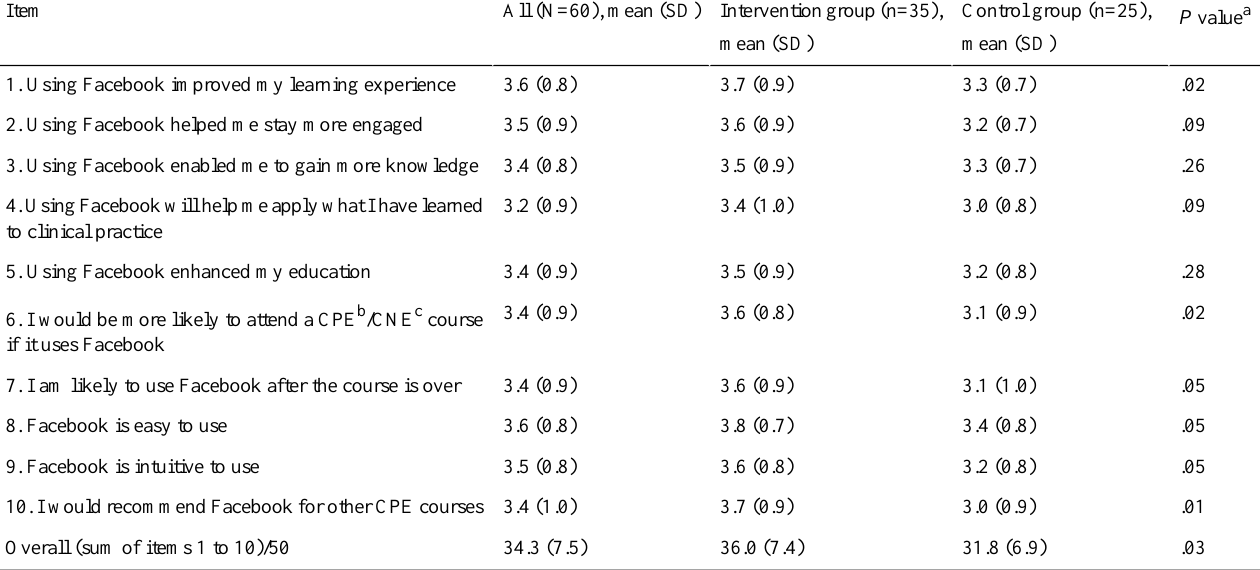
Table 6. Attitudes toward the use of Facebook for continuous professional education programs.